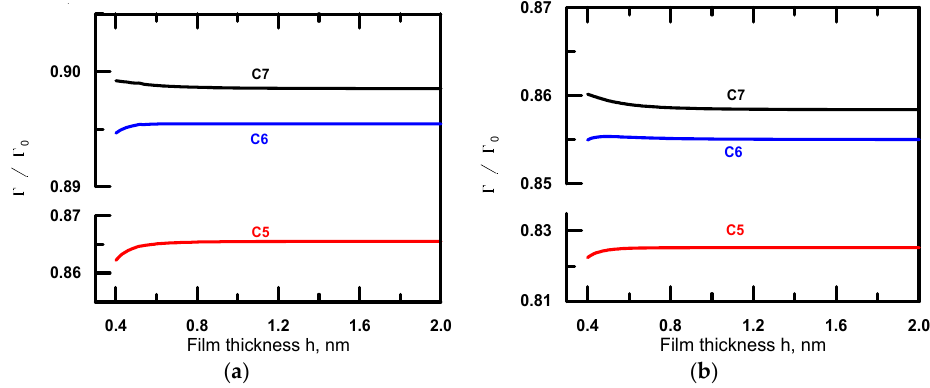
Figure 3. Adsorption isotherms of water in alkane films from pentane to heptane calculated for two different mutual locations of a dipole and a charge: ( a ) for ρ = 0; and ( b ) for ρ = ρ 0,q = 1 nm. 3. Image ‐ Charge Contribution to the Disjoining Pressure in Alkane Wetting Films on Water and its Influence on the Wettability